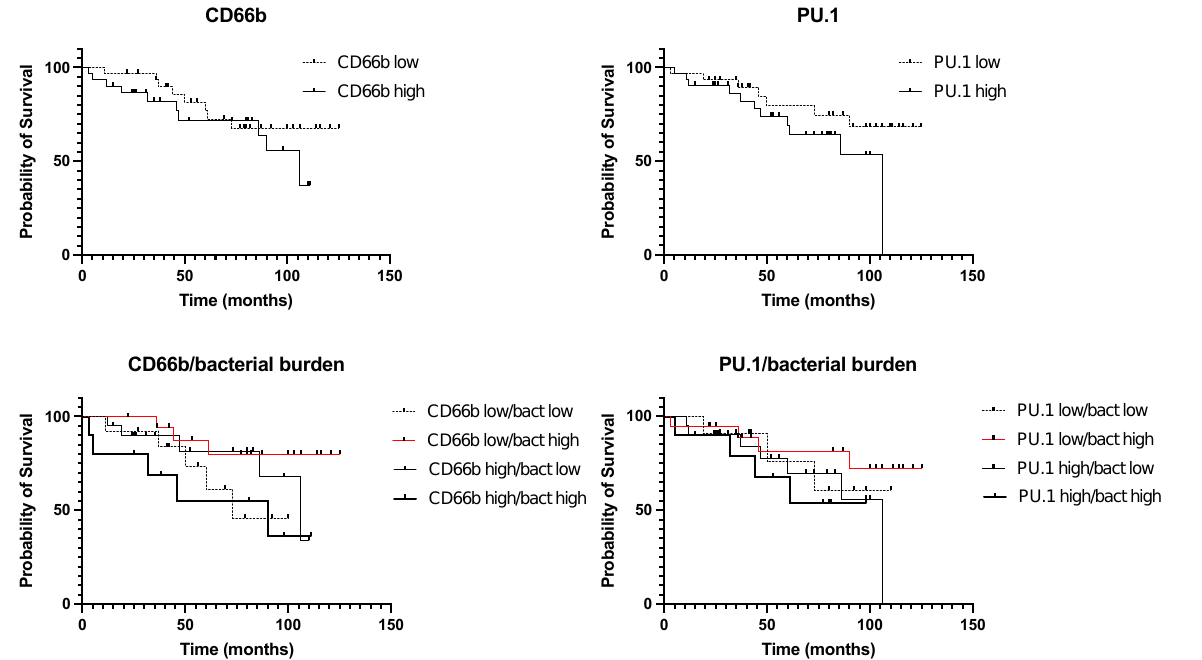
Figure 9. Prognostic significance of the total bacterial load and cell phenotype of the tumor infiltrate.